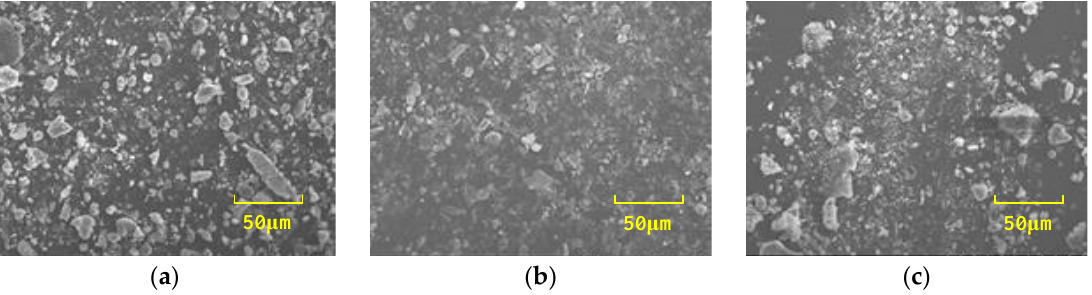
Figure 1. Scanning electron microscopy diagram of typical contaminated particle samples: ( a ) +800 kV (DC); ( b ) −800 kV (DC); and ( c ) 1000 kV (AC).